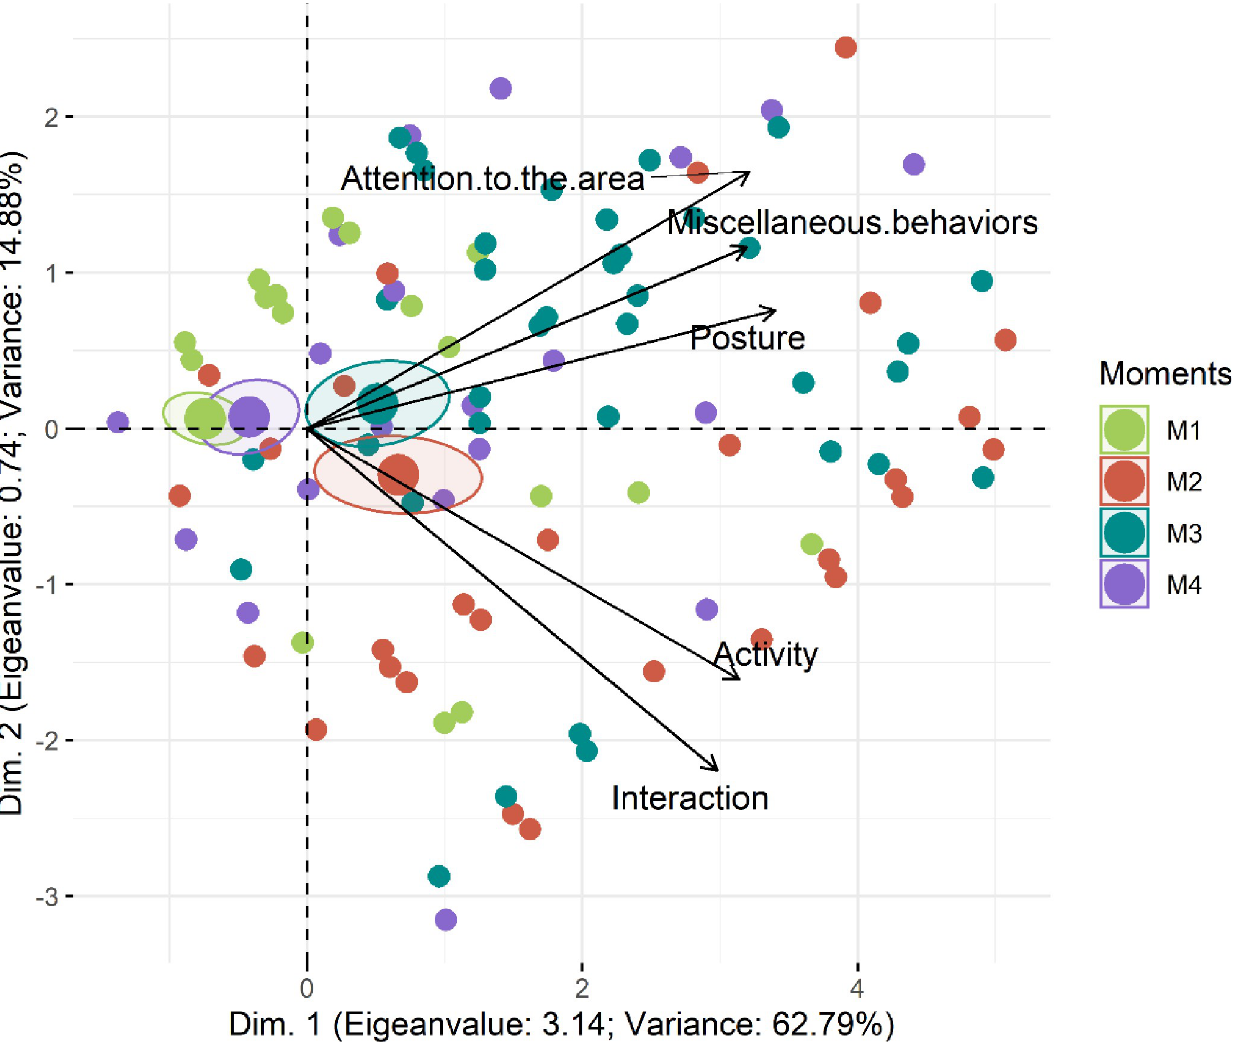
Fig 5. Biplot of the principal component analysis of the UPAPS items applied to all castrated piglets (n = 39). UPAPS–Unesp-Botucatu pig acute composite pain scale. Confidence ellipses indicate perioperative moments and pain scores. Moments: M1 (24h pre-procedure), M2 (15-min post-procedure, before rescue analgesia), M3 (3h post-procedure, after rescue analgesia), M4 (24h post-procedure). Ellipses were constructed according to the assessment. Each circle corresponds to the score from one observer attributed to each piglet at each moment.